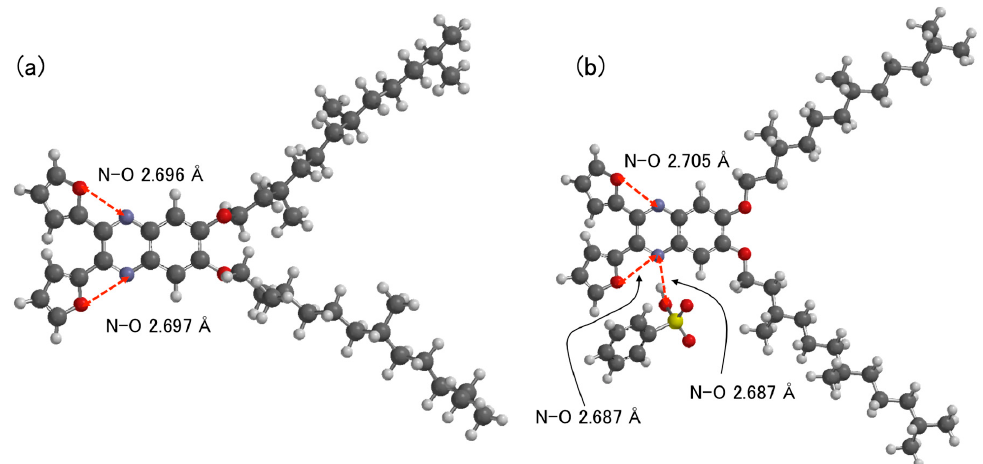
Figure 1. Top and side views of the optimized molecular geometry of ( a ) 6,7-bis(3,7,11-trimethyl-1-dodecyloxy)-2,3-difurylquinoxaline (RP N L 1) and ( b ) RP N L 1 with benzene sulfonic acid (BSA), as calculated at the B3LYP/6-31G* level.